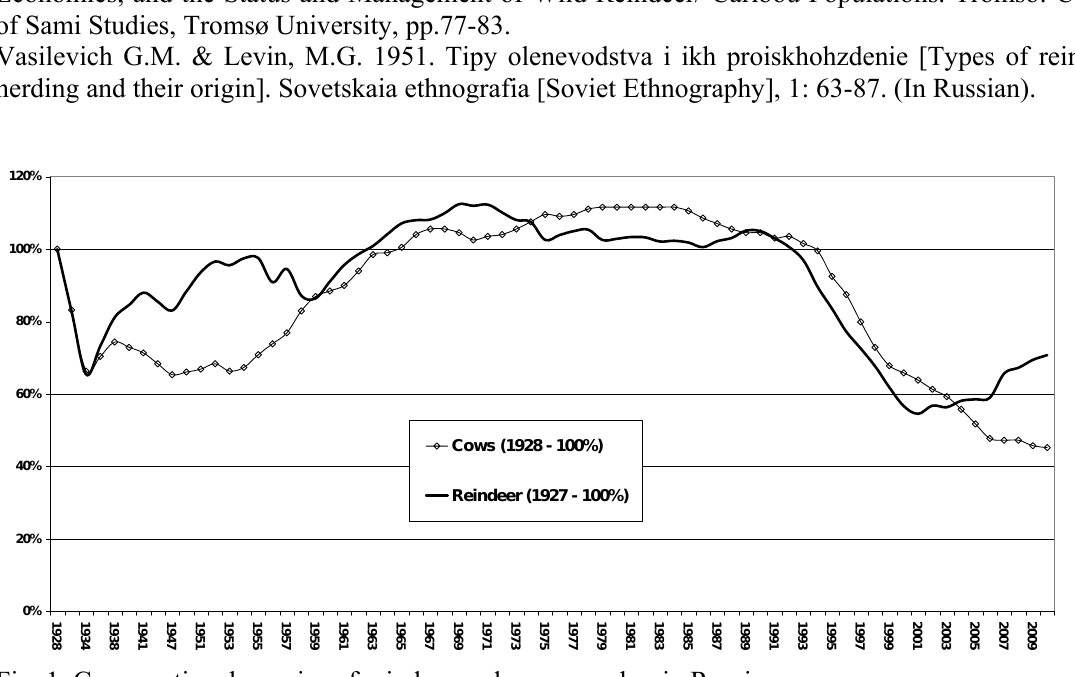
Fig. 1. Comparative dynamics of reindeer and cows number in